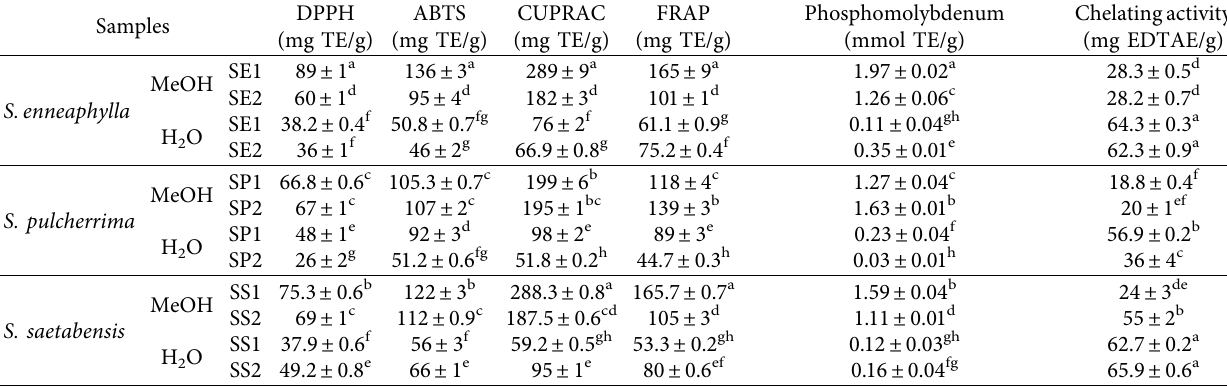
Table 6: Antioxidant activities of the extracts of S. enneaphylla (SE), S. pulcherrima (SP), and S. saetabensis (SS), each one from two different locations, extracted in methanol and water.